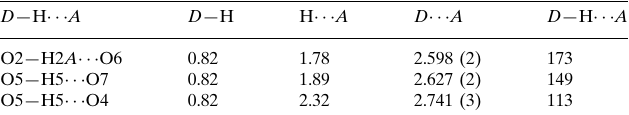
Hydrogen-bond geometry (A˚ , (cid:2)